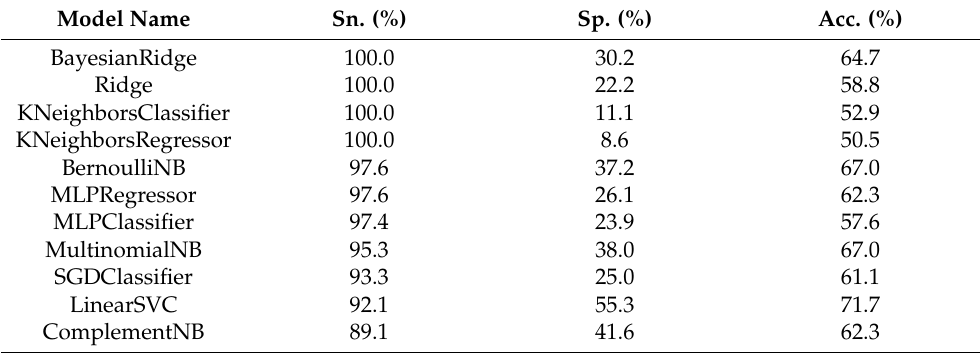
Table A2. Model output (loss function with ratio of 1:3, ratio of training and testing examples 50%:50% for the EXAI dataset, sorted descending by